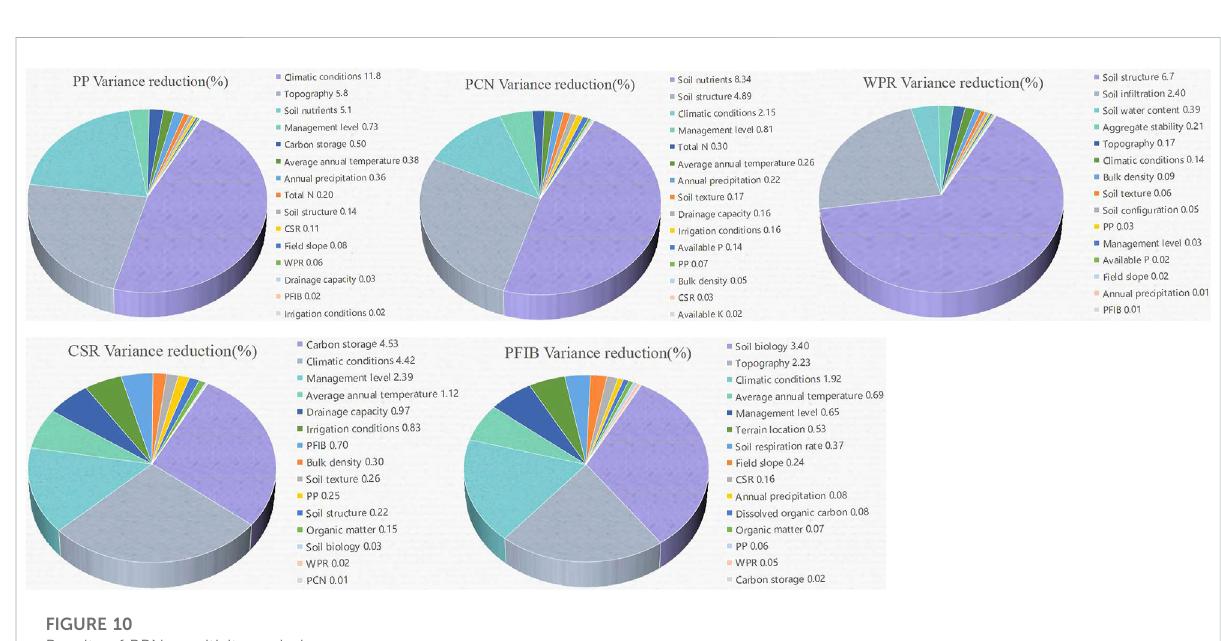
FIGURE 10 Results of BBN sensitivity